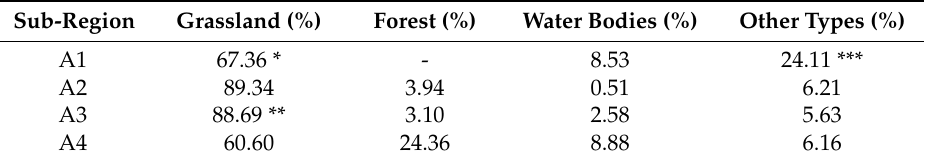
Table 1. Land cover data of study